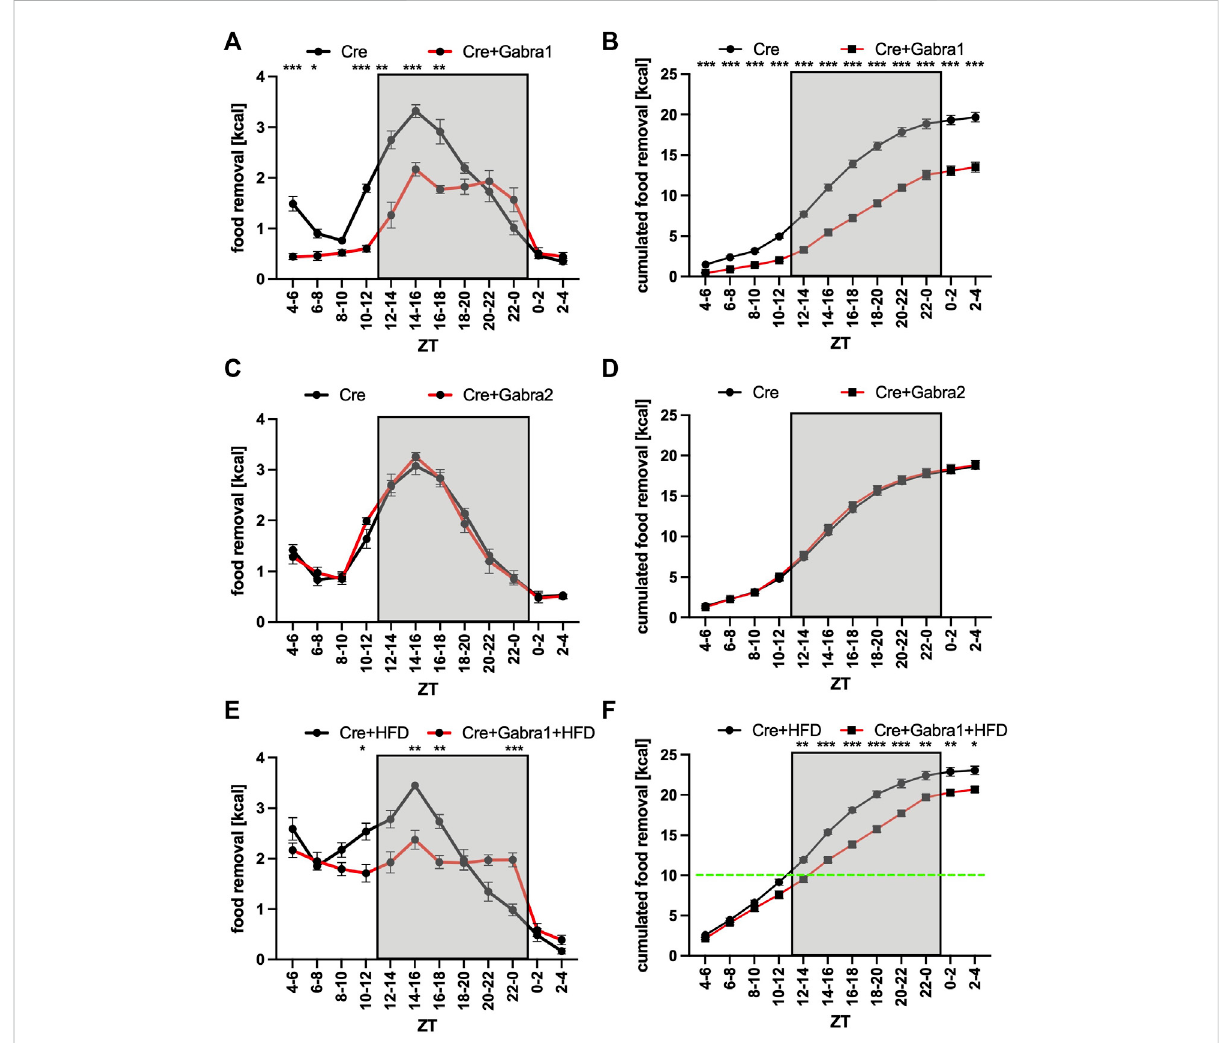
FIGURE 4 IncreaseoffoodremovalduringtheearlyactivityphasereliesonGabra1inthePVNregion. (A) Foodremovalineach2 hbinstartingfromZT4-6 for WT (black) or Gabra1 fl oxed/ fl oxed (red) mice injected with Cre into both PVN regions (2-way repeated measure ANOVA, N = 12, p < 0.001, F = 51.85, DFn = 1, DFd = 22). (B) Accumulation of food removal over the course of the experiment 4A (2-way repeated measure ANOVA, N = 12, p < 0.001, F = 103.95, DFn = 1, DFd = 22). (C) Food removal in each 2 h bin starting from ZT4-6 for WT (black) or Gabra2 fl oxed/ fl oxed (red) mice injected with Cre into both PVN regions (2-way repeated measure ANOVA, N = 12, p = 0.83, F = 0.05, DFn = 1, DFd = 22). (D) Accumulation of food removal over the course of the experiment 4C (2-way repeated measure ANOVA, N = 12, p = 0.61, F = 0.27, DFn = 1, DFd = 22). (E) Same mice as (A) but with high-fat diet (2-way repeated measure ANOVA, N = 12, p = 0.001, F = 14.23, DFn = 1, DFd = 22). (F) Accumulation of food removal over the course of the experiment 4E (2-way repeated measure ANOVA, N = 12, p < 0.001, F = 32.50, DFn = 1, DFd = 22). A green line indicates the transition fromhigh-fat tonormal diet.Tocorrectformultipletesting,the Š idák ’ sposthoctestwasemployed; *: p < 0.05;**: p < 0.01;***: p < 0.001.Shownis the mean ±